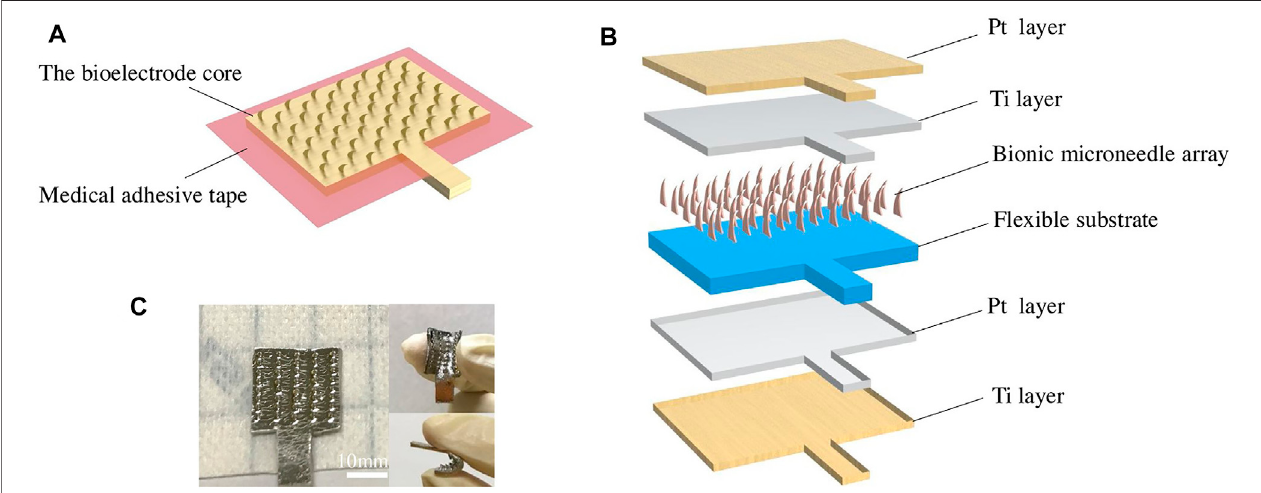
FIGURE8| Designofthe fl exibledrybioelectrode: (A) assemblingdiagramofa fl exibledrybioelectrode; (B) schematicdiagramofanelectrode corestructure;and (C) optical picture of a fl exible dry bioelectrode. Reproduced with permission (Li Y. et al., 2021). Copyright 2021, Elsevier.